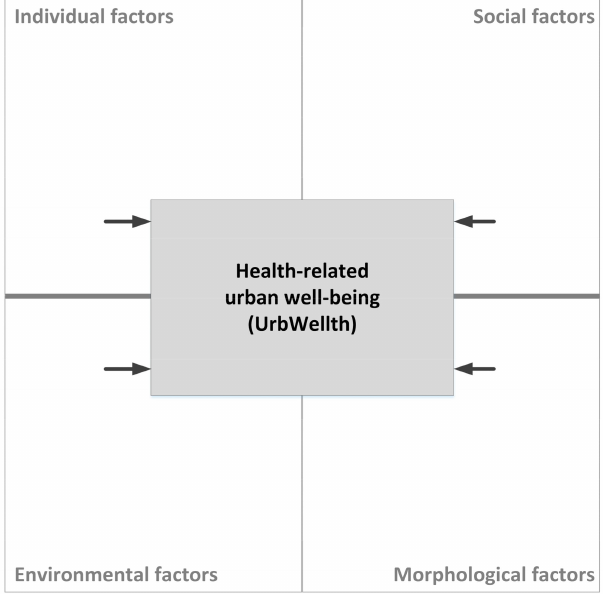
Figure 1. Simplified model of UrbWellth (modified from von Szombathely et al.